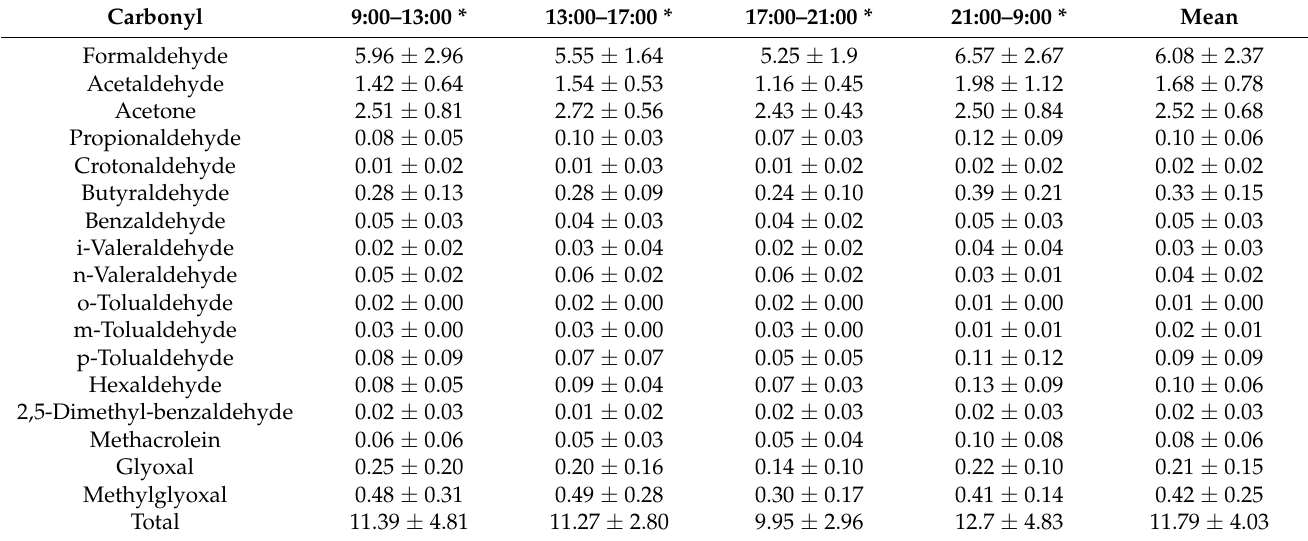
Table 1. Average ± SDs of carbonyl concentrations in each time period in Tazhong (units: